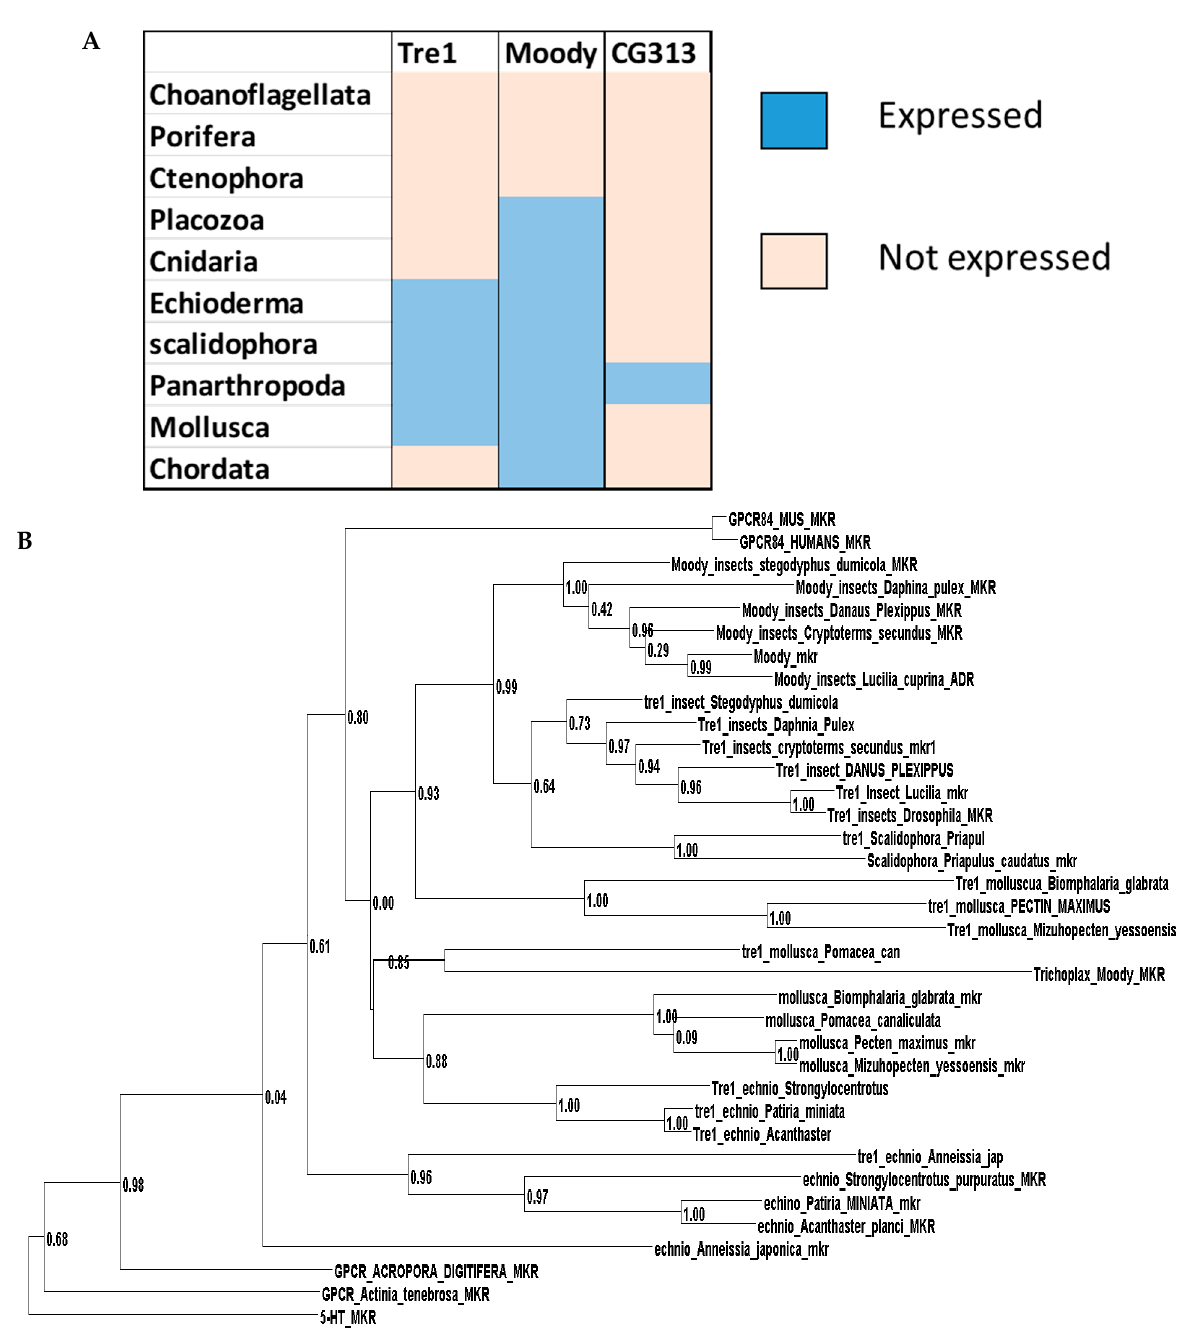
Figure 1. Evolutionary history of the Tre1 family. ( A ) moody seems to be the oldest family in the Tre family tree, whereas CG4313 seems to be expressed only in insects. ( B ) The phylogenetic tree shows that moody and Tre1 were orthologs that started to diverge in Cnidaria/Trichoplax period emergence.